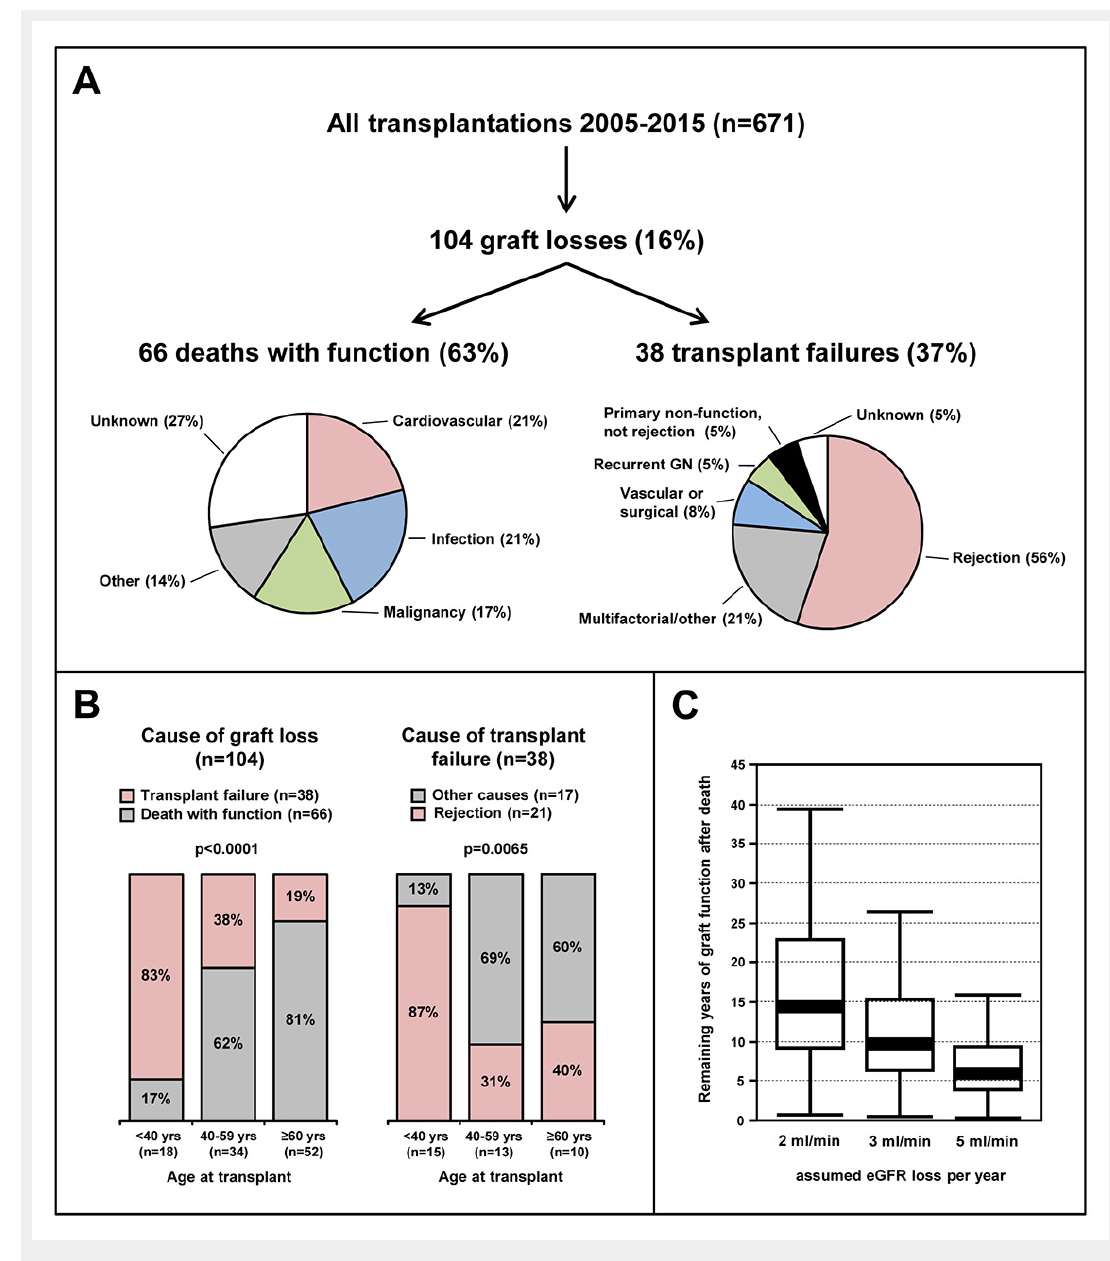
Figure 6 Reasons for graft loss in the era from 2005 to 2015. A. Distribution of reasons for graft loss. B. Causes of graft loss and transplant failure, grouped by recipient age at transplantation. C. Calculation of remaining years of graft function after death, presented as box plots. GN =